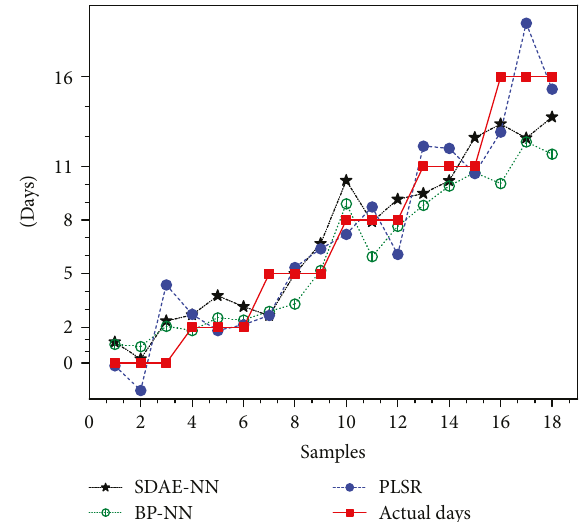
Figure 9: The predicted results of SDAE-NN, BP-NN, and PLSR models for test sets of the salmon